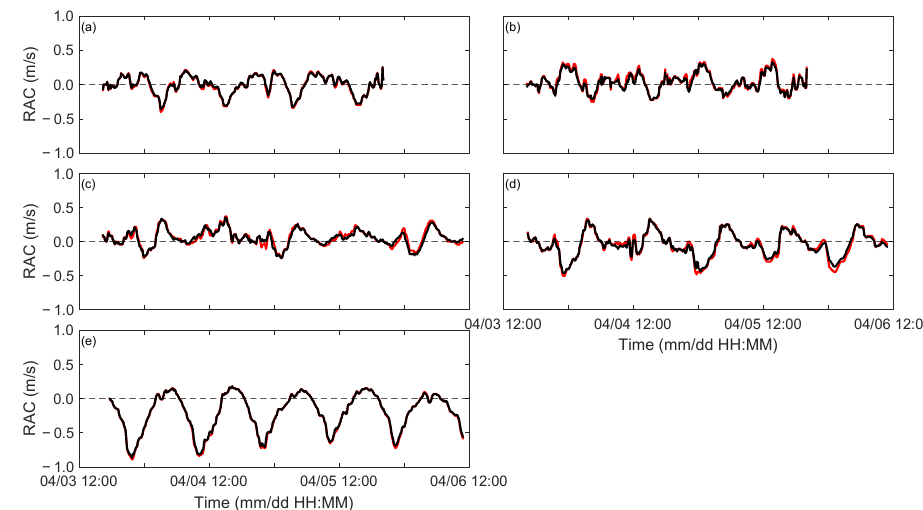
Figure 4. Comparison of range-average currents from the coastal acoustic tomography observation data (red lines) and coast-fitting method inversion results (black lines) for the transmission paths: ( a ) S1S3, ( b ) S1S4, ( c ) S2S3, ( d ) S2S4, and ( e ) S2S5. The positive current is taken in the direction from small to large station number.